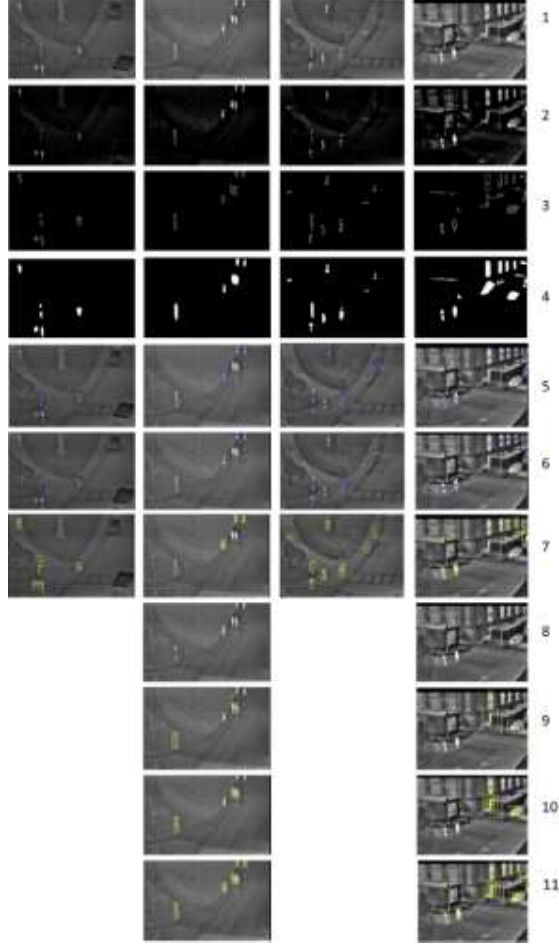
Figure 15. Classes 1 & 2 ROI detection (row 1: normalized thermal images, row 2: adjustment, row 3: edge detection of row 2 with canny edge detector, row 4: applying convex hull morphological operator, row 5: ROI center detection with possibility of presence of one pedestrian, row 6: omitting unnecessary centers, row 7: ROI block division with possibility of presence of one pedestrian, row 8: ROI center detection with possibility of presence of several pedestrians, row 9: ROI block division with possibility of presence of several pedestrians, row 10: dividing row 9 images into blocks, row 11: ROI detection with possibility of presence of pedestrians).